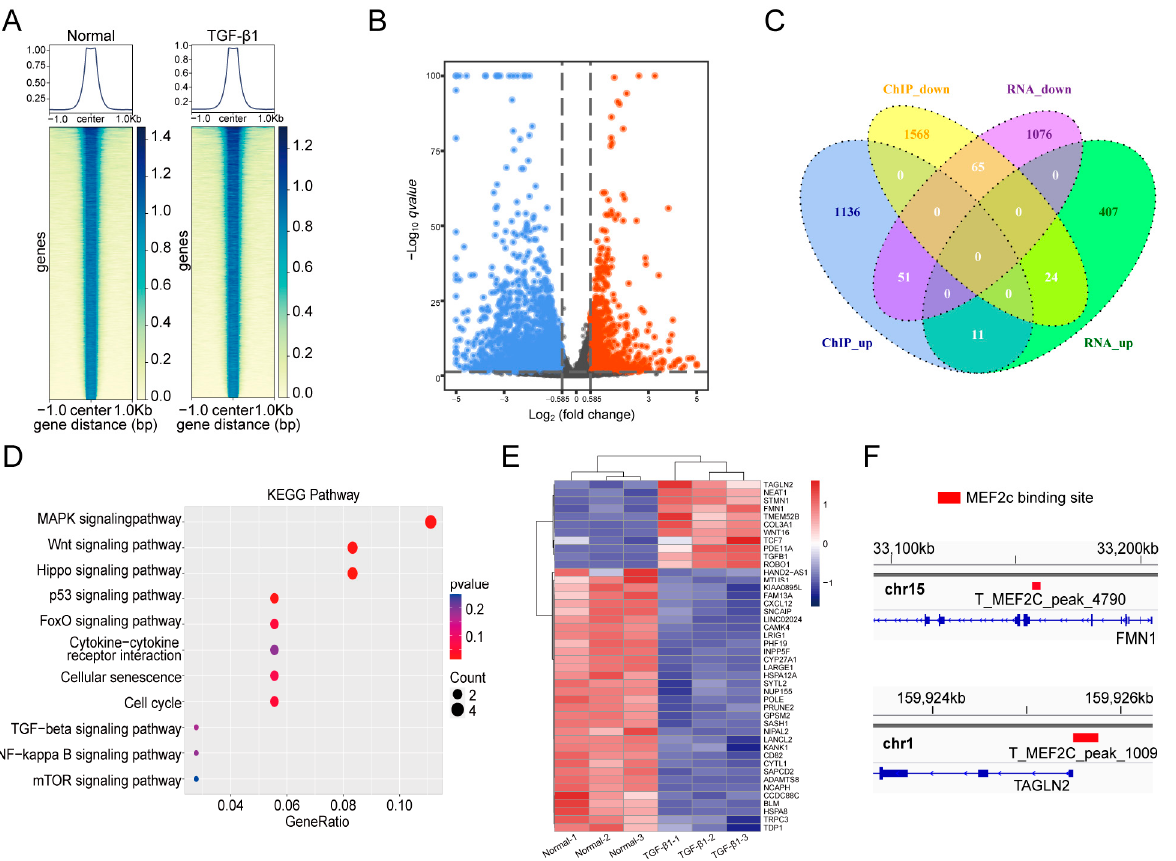
Figure 6. MOBT regulated the downstream target genes of MEF2c. ( A ) A ChIP-seq experiment was performed to identify genes binding with MEF2c. ( B ) RNA-seq was performed to analyze the differentially expressed genes. ( C ) Combined analysis revealed a total of 76 target genes in the ChIP-seq and RNA-seq data, with 11 upregulated and 65 downregulated genes. ( D ) The KEGG analysis revealed that the 76 target genes regulated by MEF2c were significantly enriched in the Hippo, Wnt, and MAPK signaling pathways. ( E ) The 44 significant differentially expressed genes that were selected from 76 target genes and listed in the hierarchical clustering of RNA-seq. ( F ) The binding sites for MEF2c in the TAGLN2 and FMN1 genes were